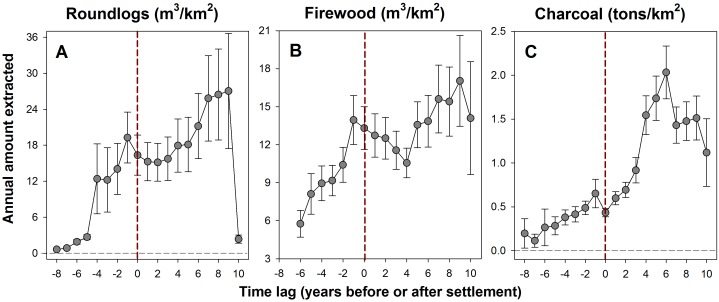
Extractive production before and after settlements.Area-weighted average extractive production of (A) raw timber (roundlogs), (B) firewood, and (C) charcoal for counties containing agrarian settlements, estimated on the basis of municipal county scale data overlapping all settlements for which annual offtake data from IBGE (2000–2010) were available (N = 424) for up to 8 years before (yr‒8) and 12 years after (yr+12) the formal establishment of settlements. Error bars indicate standard errors.